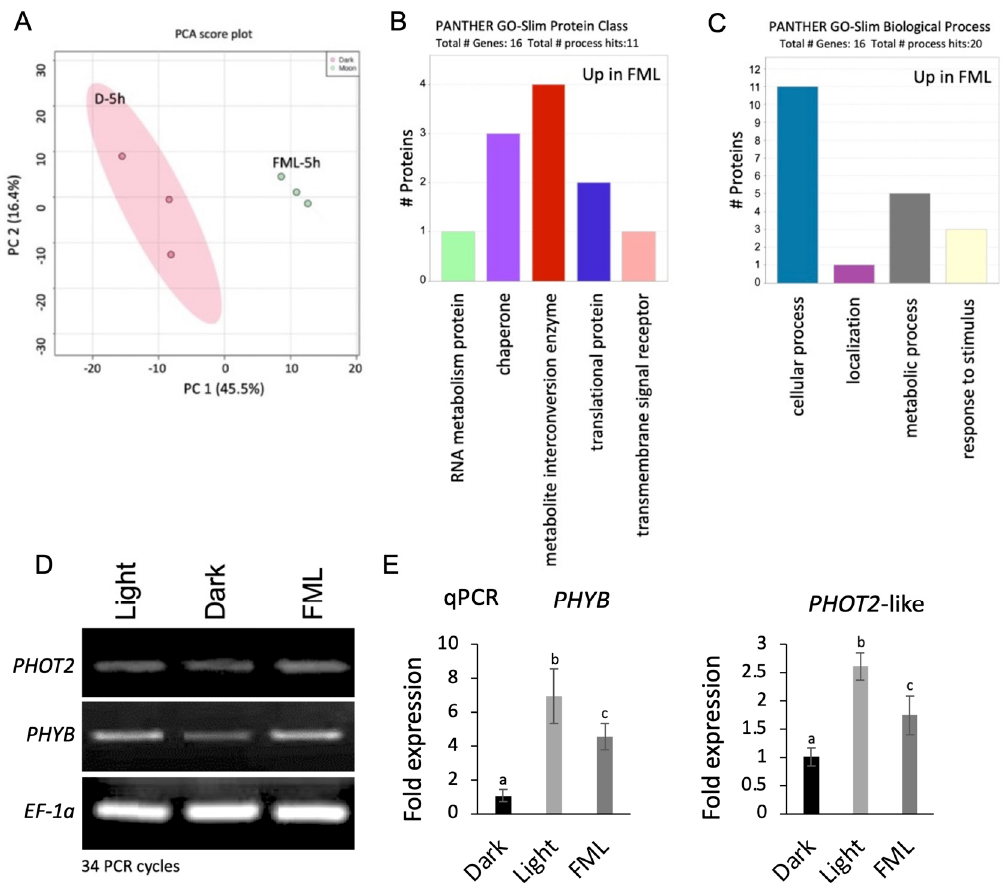
Figure 3. Proteome analysis of leaves of tobacco plants exposed to darkness and FML. ( A ) Principal component analysis (PCA) score plot comparing the proteome profiles between leaves derived from plants subjected to 5 h of darkness and 5 h of FML. ( B ) Categorization analysis (protein class) of the 17 DEPs upregulated under FML treatment. ( C ) Biological process. Categorization analysis was performed using a PANTHER bioinformatic. ( D ) Semiquantitative PCR demonstrating the expression of PHYB and PHOT2 genes under light, darkness and FML. ( E ) Real-time PCR (qPCR) showing the fold expression of PHYB and PHOT2 under dark, light and FML. EF1 α was used as a control gene. Statistical significance was performed using a One-Way ANOVA Calculator, Including Tukey HSD (Social Science Statistics). Different letters indicate statistically significant differences between treatments ( p < 0.05). qPCR was performed twice, each with 3